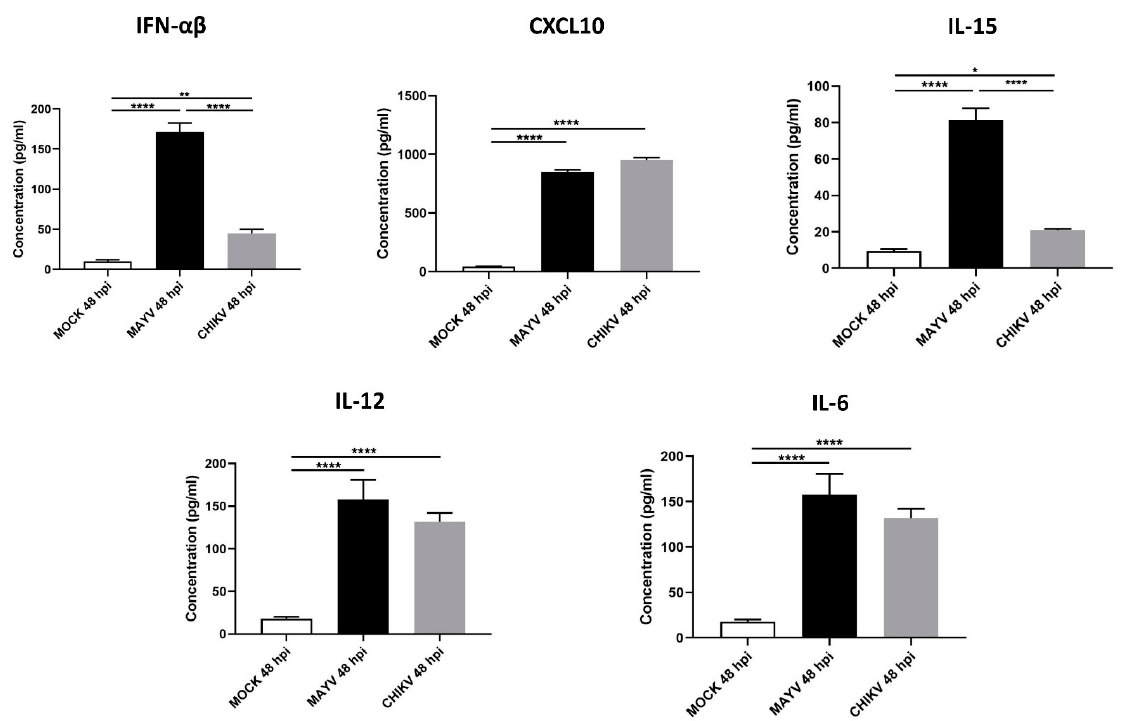
Figure 4. MAYV-infected human astrocytes produce high levels of inflammatory mediators. Supernatants of MAYV-, CHIKV- and mock-infected astrocytes at MOI 5 were harvested at 48 hpi and analyzed by ELISA. IFN- α / β , CXCL10, IL-15, IL12 and IL-6 cytokine levels were quantified and their values expressed in pg/mL. Statistical analysis was performed from three independent experiments each performed in triplicate. T-test was performed and comparisons were made between MAYV- versus CHIKV-infected cells. * represents p < 0.05, ** represents p < 0.005, **** represents p < 0.0001,